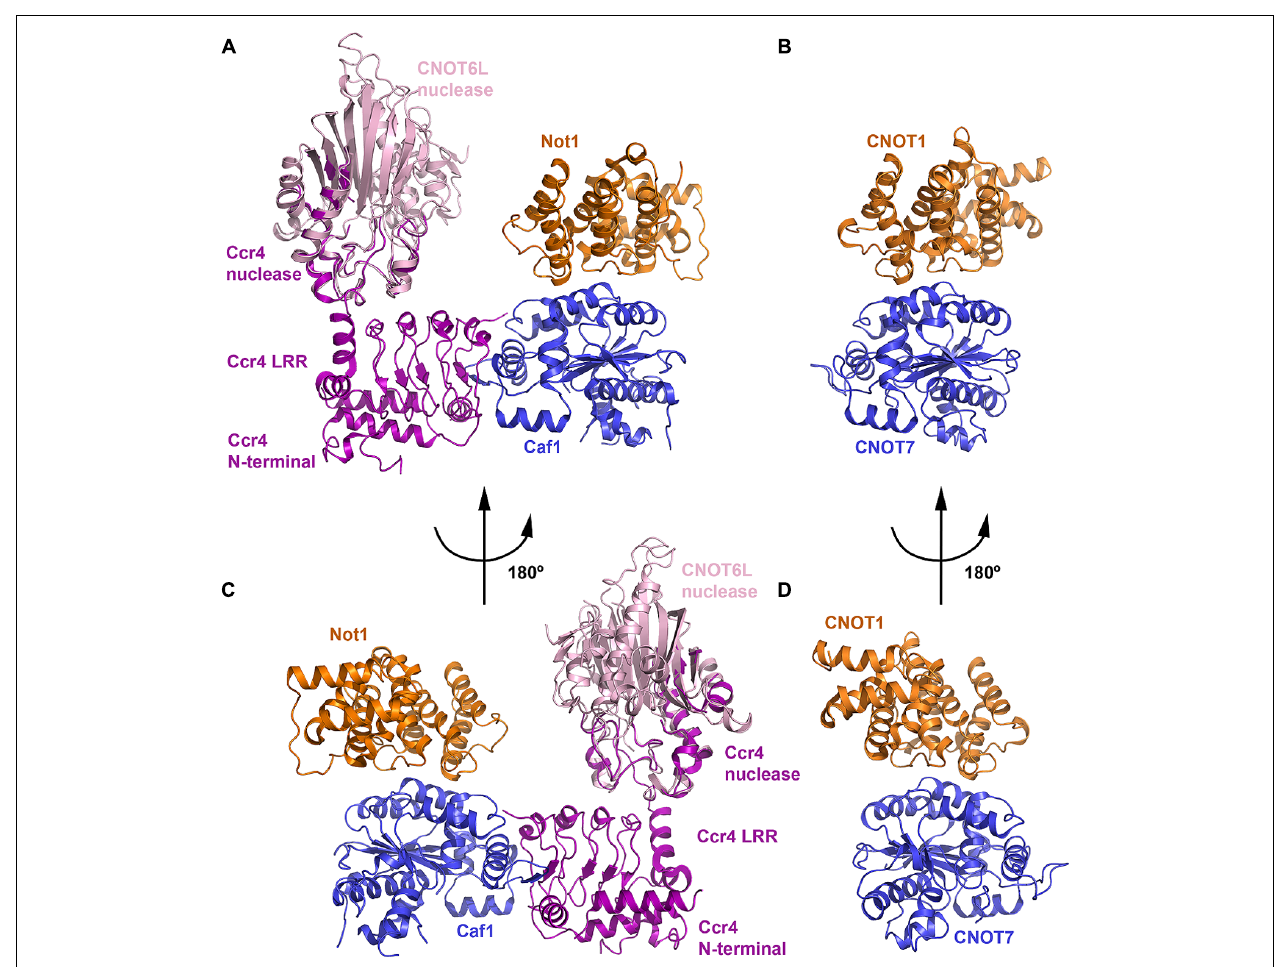
(PDB ID: 4GMJ). The CNOT MIF4G domain (orange) and CNOT7 (blue) are colored according to their orthologs in (A) . The view shown is the same orientation as (A) . (C) View of the Not1–Ccr4–Caf1 ternary complex related to the view in panel A by a rotation of 180 ◦ . (D) View of the CNOT1–CNOT7 binary complex related to the view in (B) by a rotation of 180 ◦